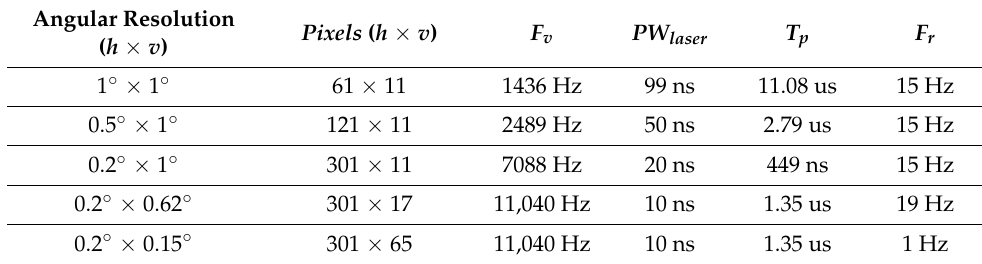
Table 1. Parameters for different angular resolutions.